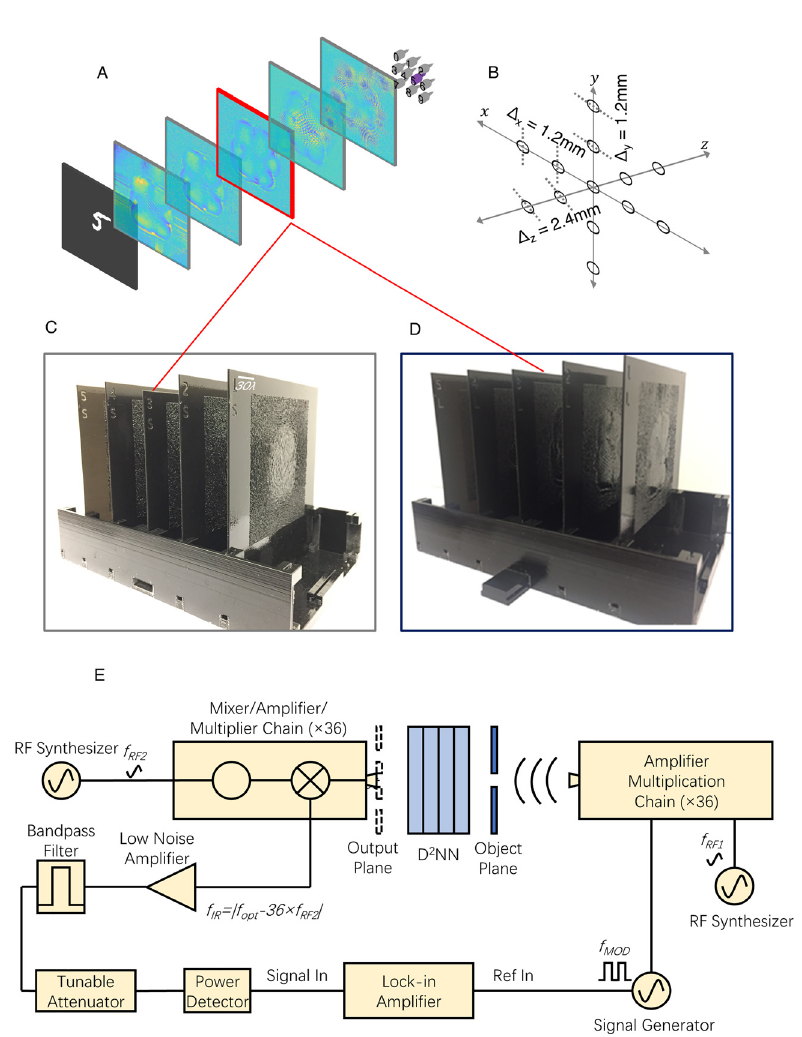
Figure 1E. (D) The 3D printed vaccinated design shown in A and Figure 1D. (E) The schematic of the experimental